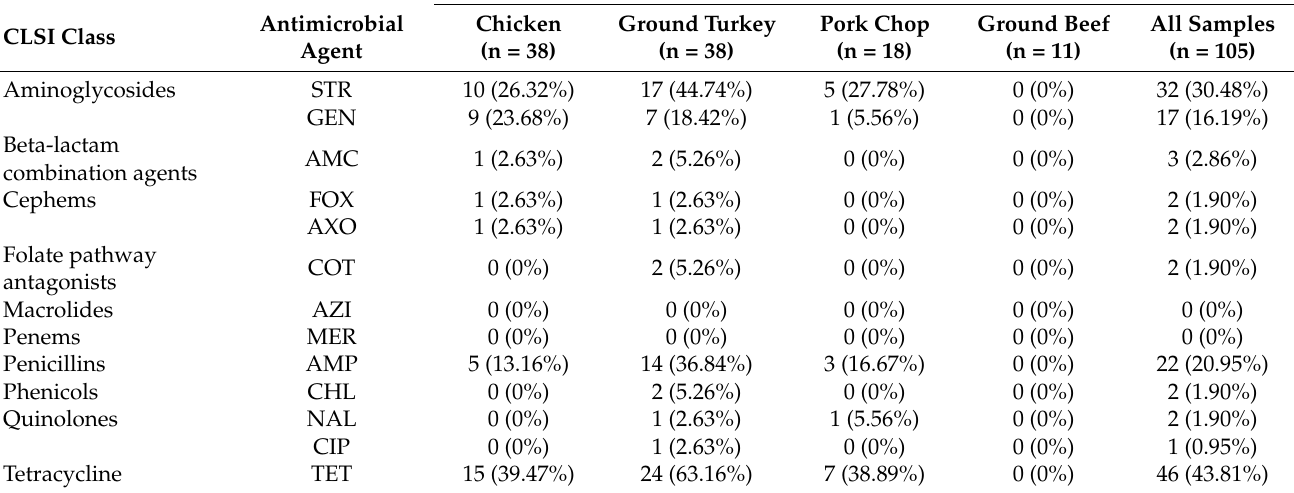
Table 2. Distribution of phenotypic antimicrobial resistance in E. coli isolates from retail meat samples (n =